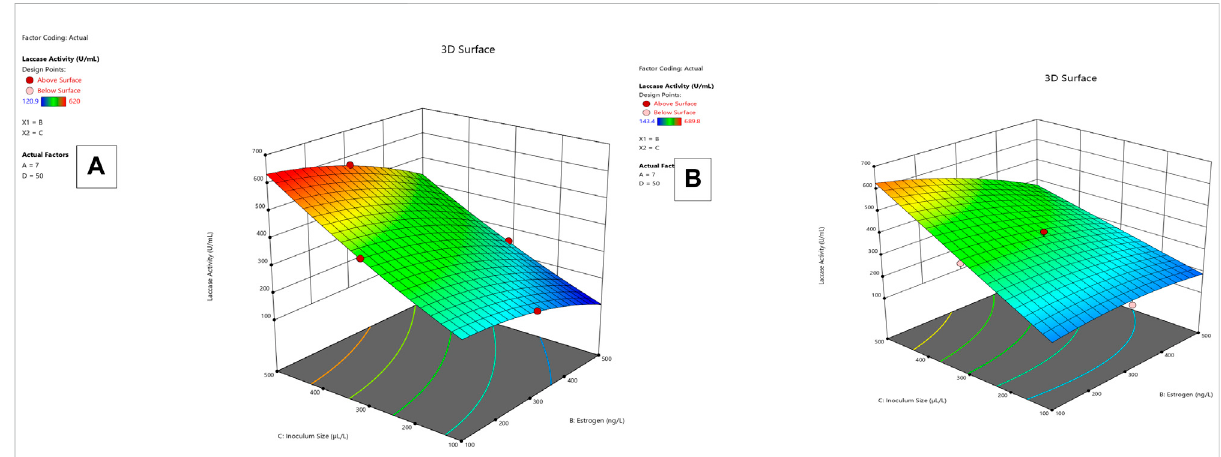
FIGURE 1 R1 and R2 response 3D mesh diagram for both Lysinibacillus. BP1 (A) and Lysinibacillus. BP2 (B) .